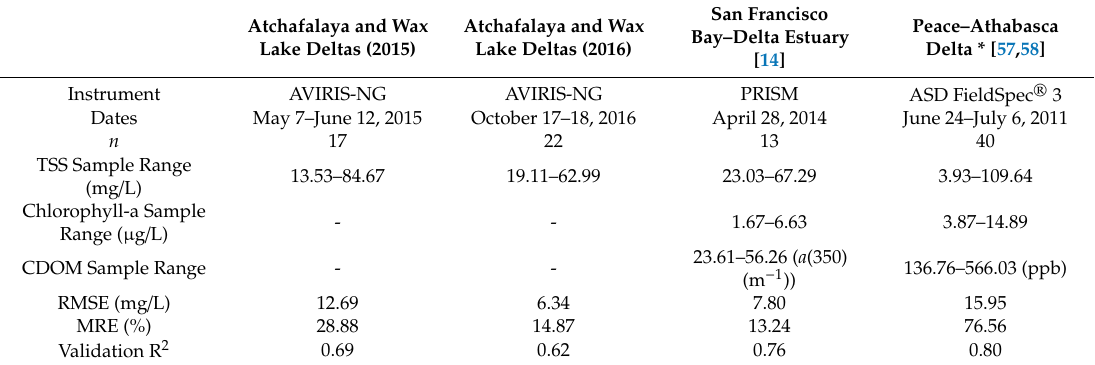
Table 3. Validation data and results for the derivative-based PLSR